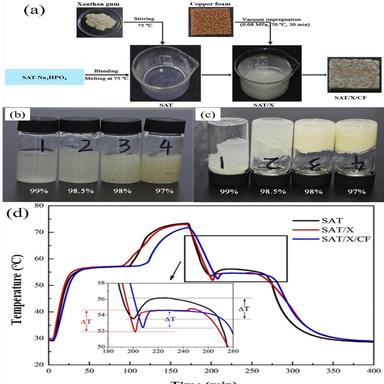
(a) Preparation process of SAT/X/CF composite PCMs, (b) photographs of sample bottles loaded with SAT/X before (b) and after heating (c) and temperature–time curves of SAT, SAT/X and SAT/X/CF Reproduced with the permission of Elsevier.